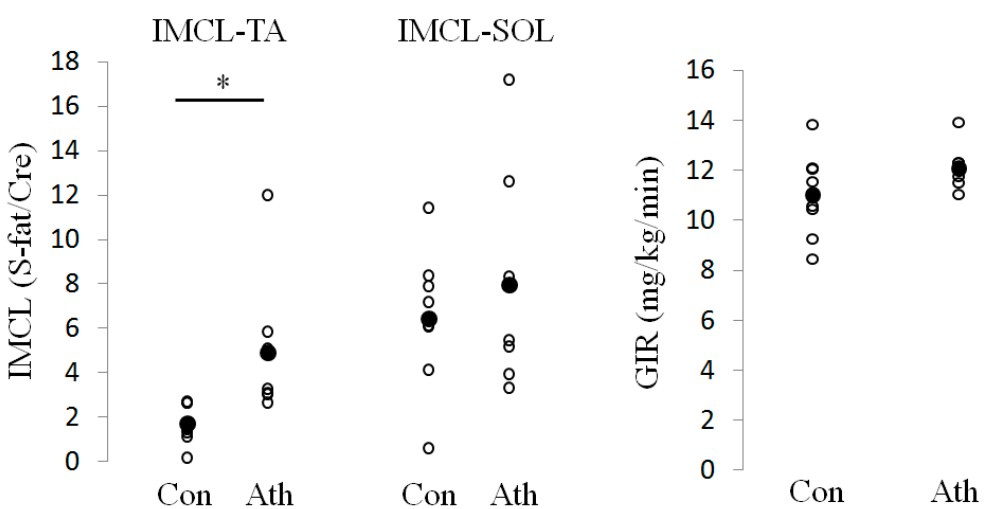
Figure 1. Absolute intramyocellular lipid (IMCL) and glucose infusion rate (GIR) levels in the control and athlete groups. Absolute values of GIR and IMCL in the control group (Con) and athlete group (Ath). The average in each group is shown as closed circle. * p < 0.05 Intramyocellular lipid, IMCL; tibialis anterior, TA; soleus, SOL; methylene signal intensity, S-fat; creatine signal, Cre.